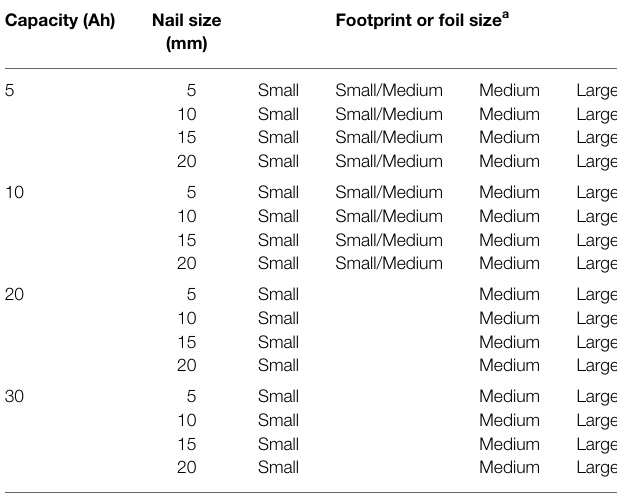
TABLE 3 | Test matrix for baseline internal cell structure